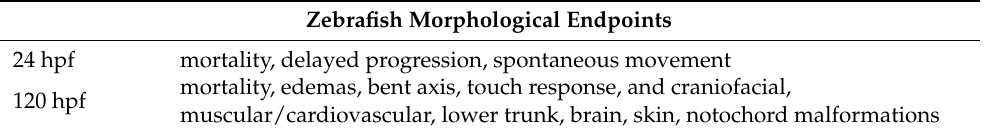
Table 5. Zebrafish morphology endpoints assessed at 24 and 120 h post